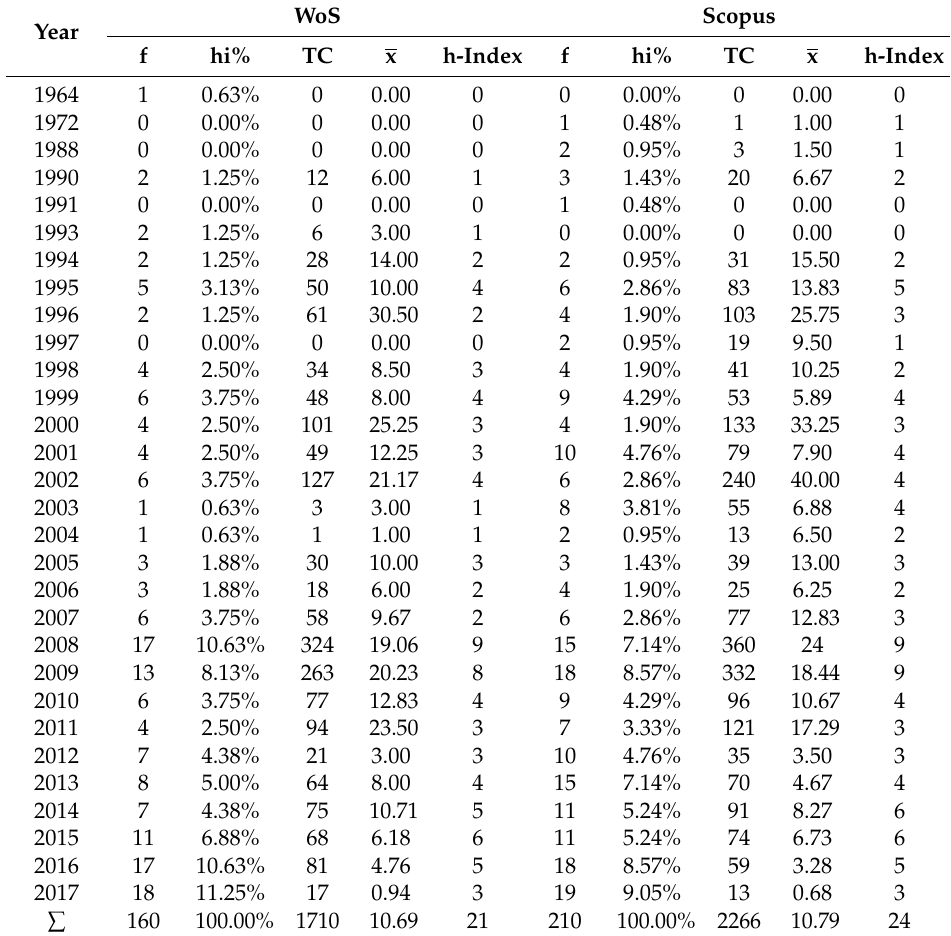
Table 2. Number of articles and citations per year on Sustainable Water Resources Management in the WoS and Scopus